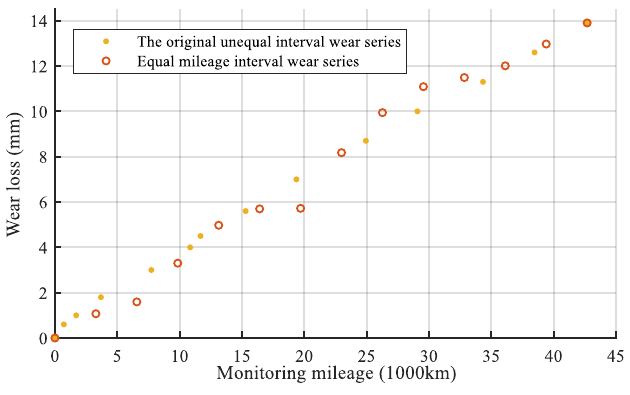
Figure 9. The conversion process.